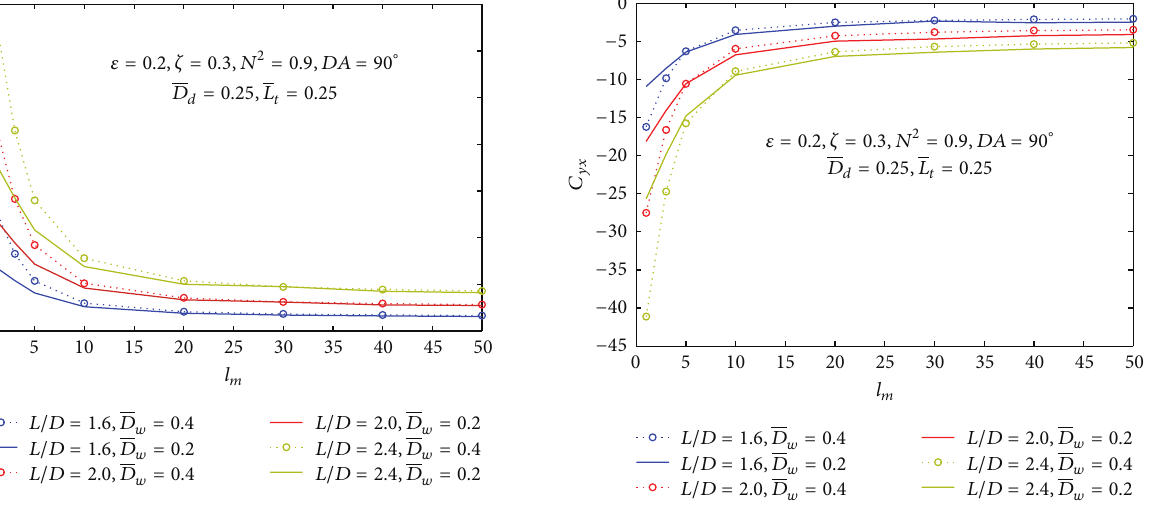
Figure 9: Variation of C 𝑥𝑥 as a function of characteristics length .” “ l m